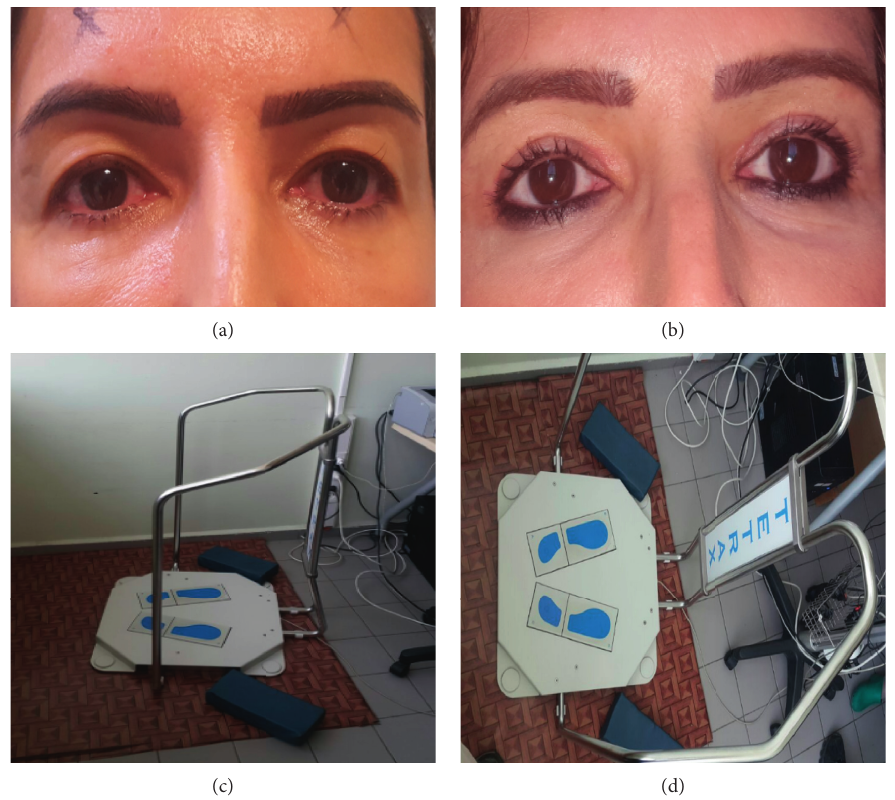
Figure 1: (a) Upper eyelid appearance before dermatochalasis surgery. (b) 1st month after surgery. (c) A computer-based static posturography device with balance function measurements. (d) The foot platform of the device and the foam used in the different stages of the